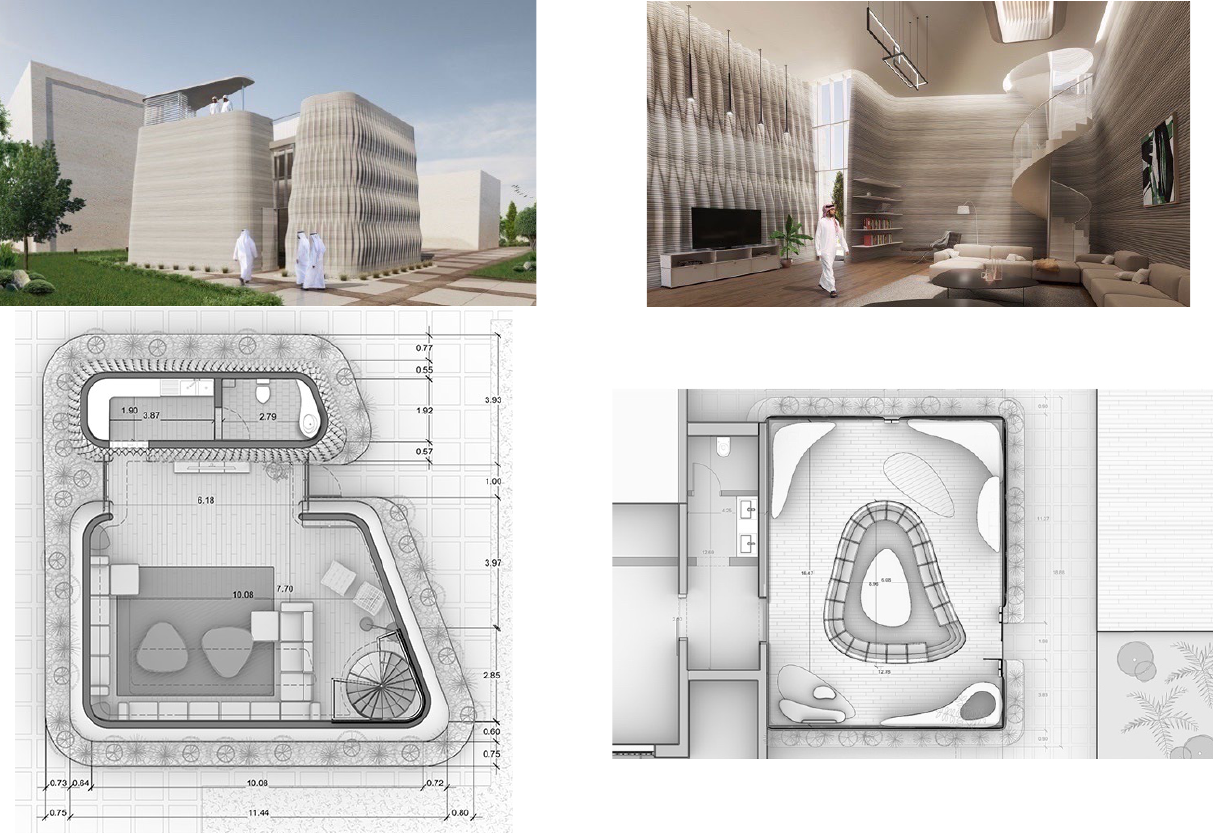
Figure 11. A 3D-printed guest house and floor plans for levels 1 and 2